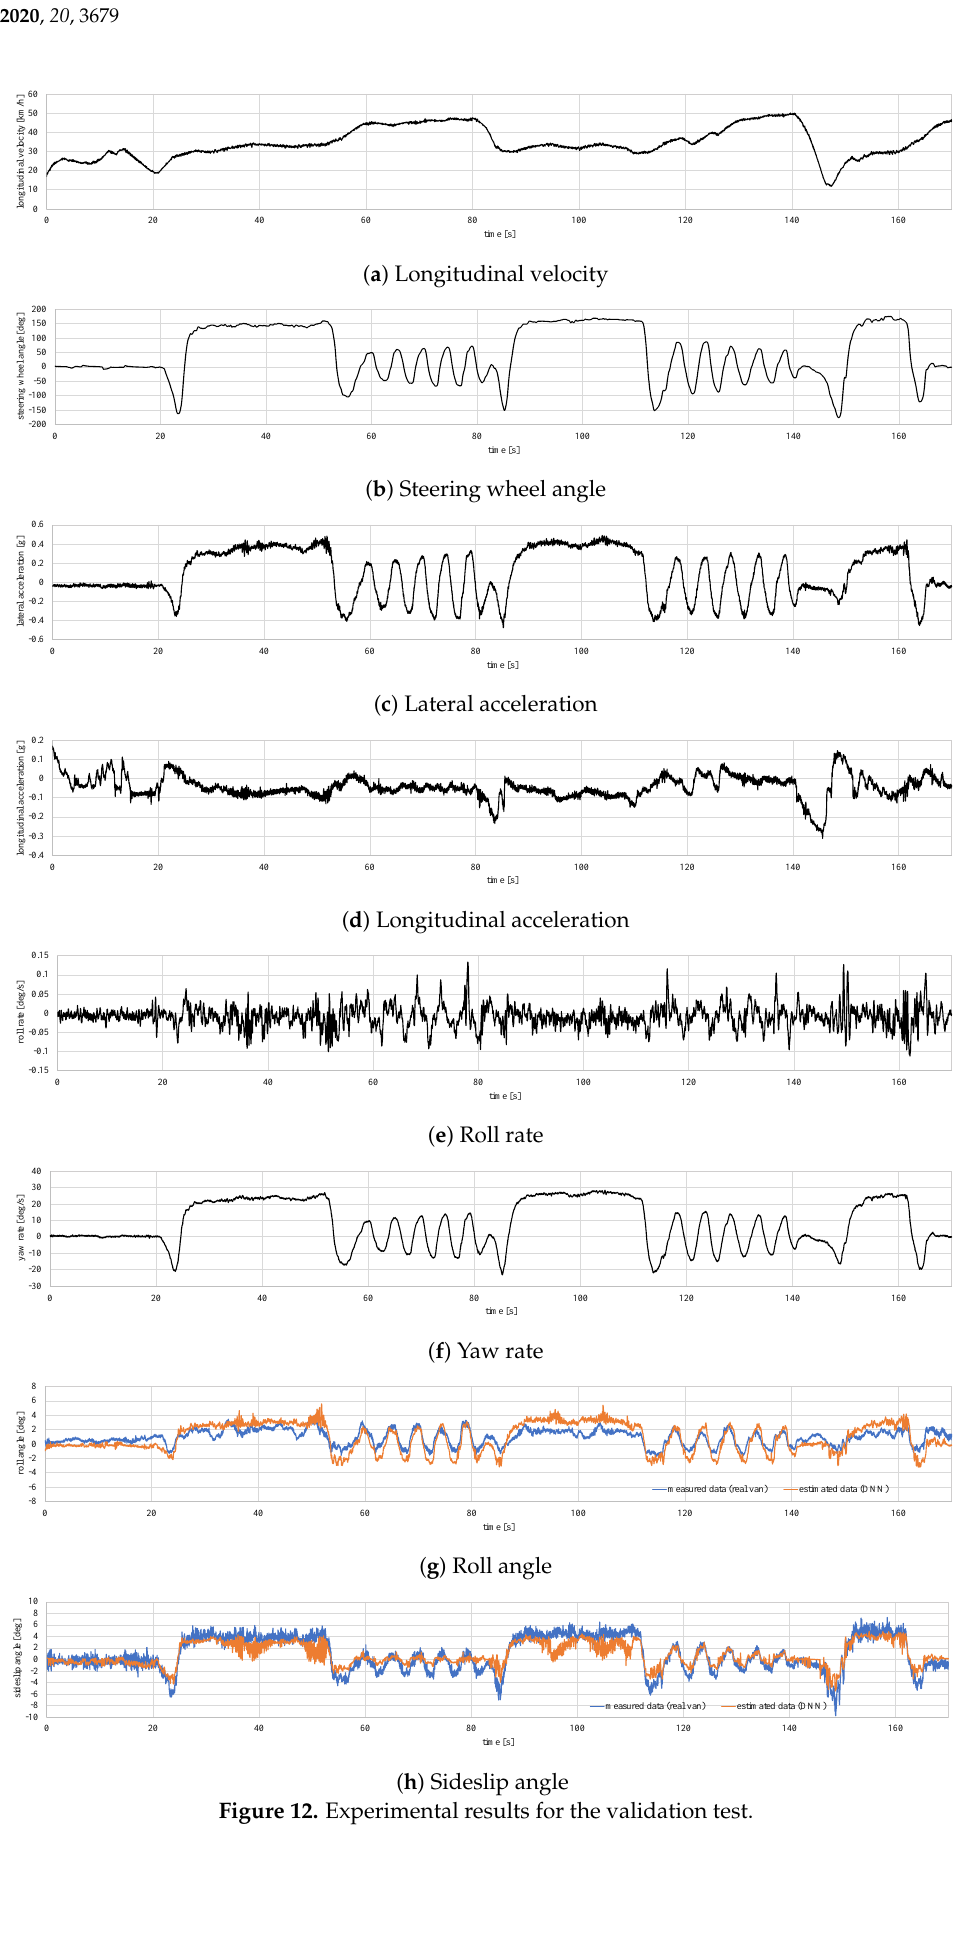
Figure 12. Experimental results for the validation